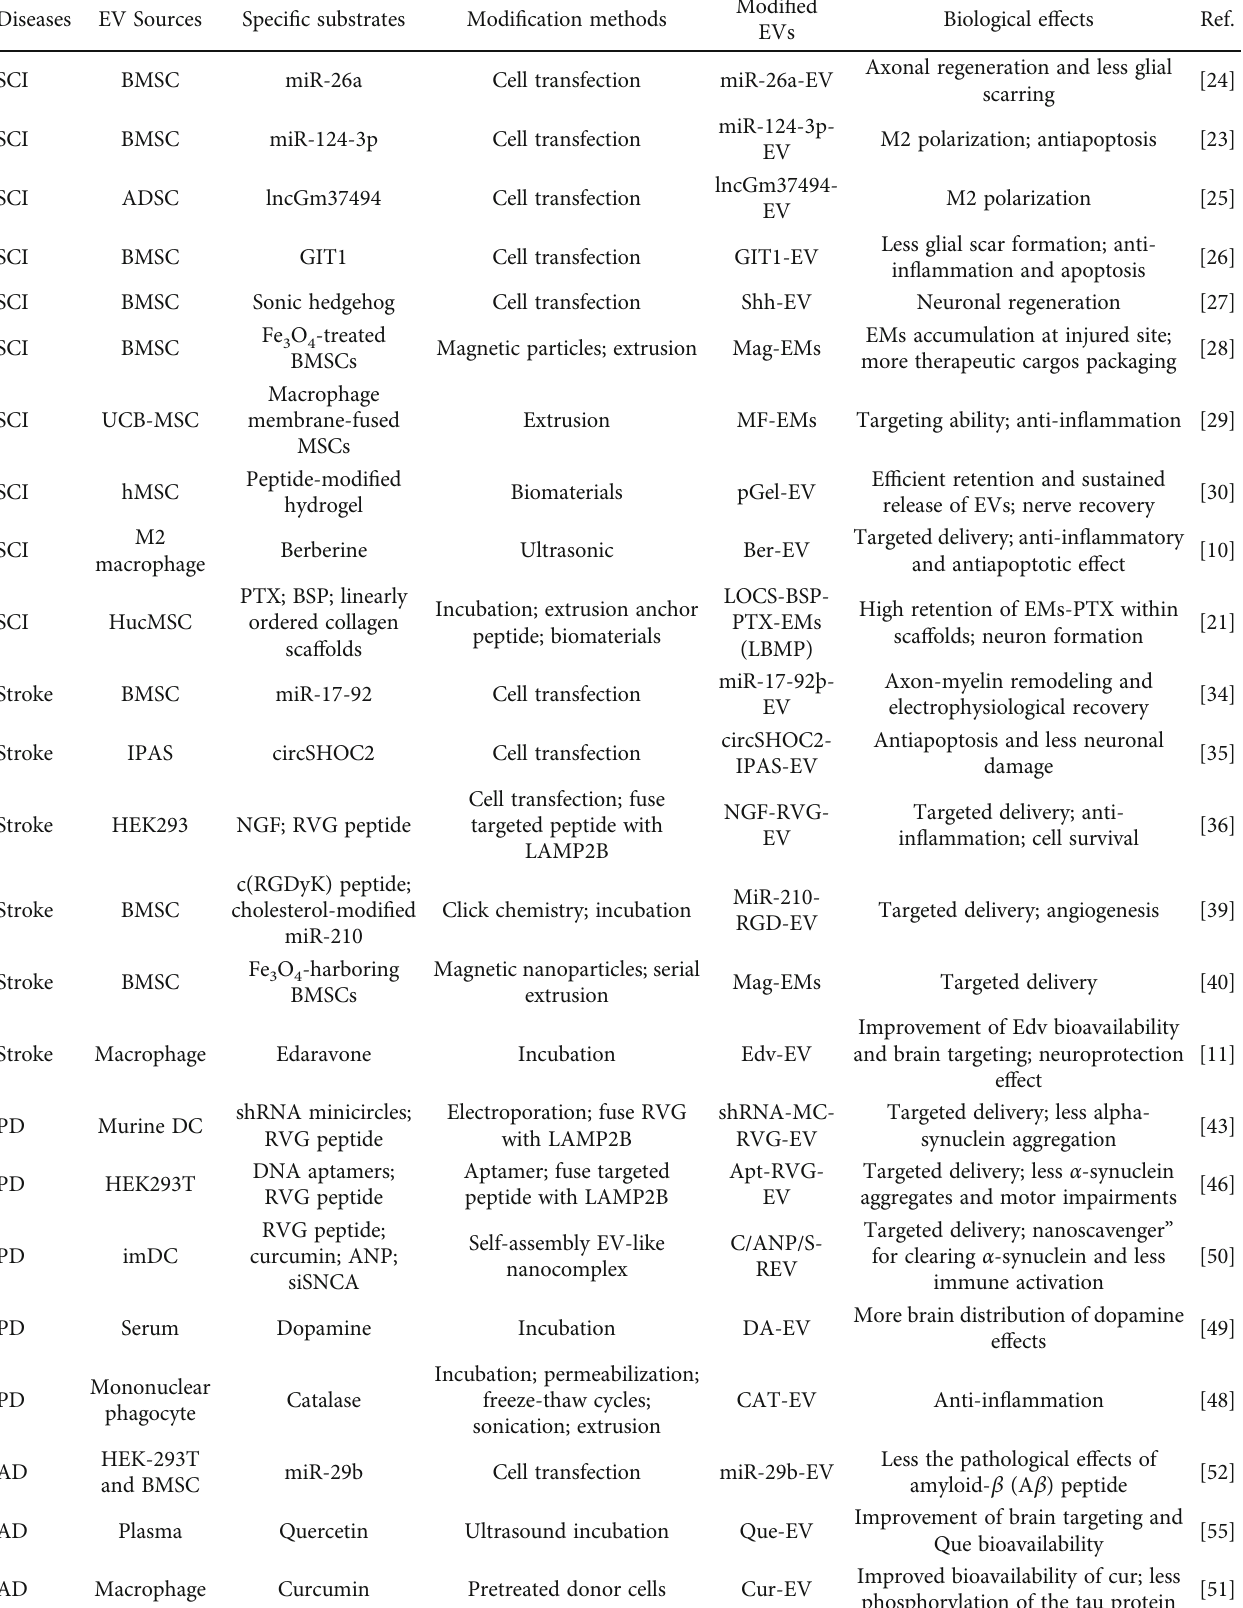
Table 1: Modi fi ed EVs in the therapy of neurological